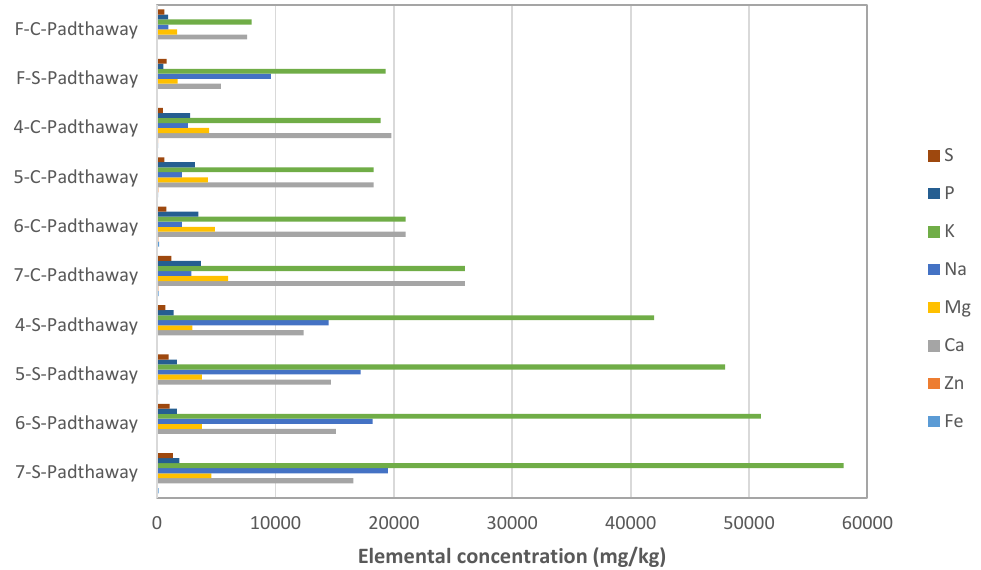
Figure 2. Elemental analysis by ICP-AES. Sample Identification: F = Feedstock sample, C = Grapevine Cane, S = Stalks, 4 = 400 °C Biochar, 5 = 500 °C Biochar, 6 = 600 °C Biochar, 7 = 700 °C Biochar. Co, Mo, Cd, Pb, As, and Se all below detection limit.